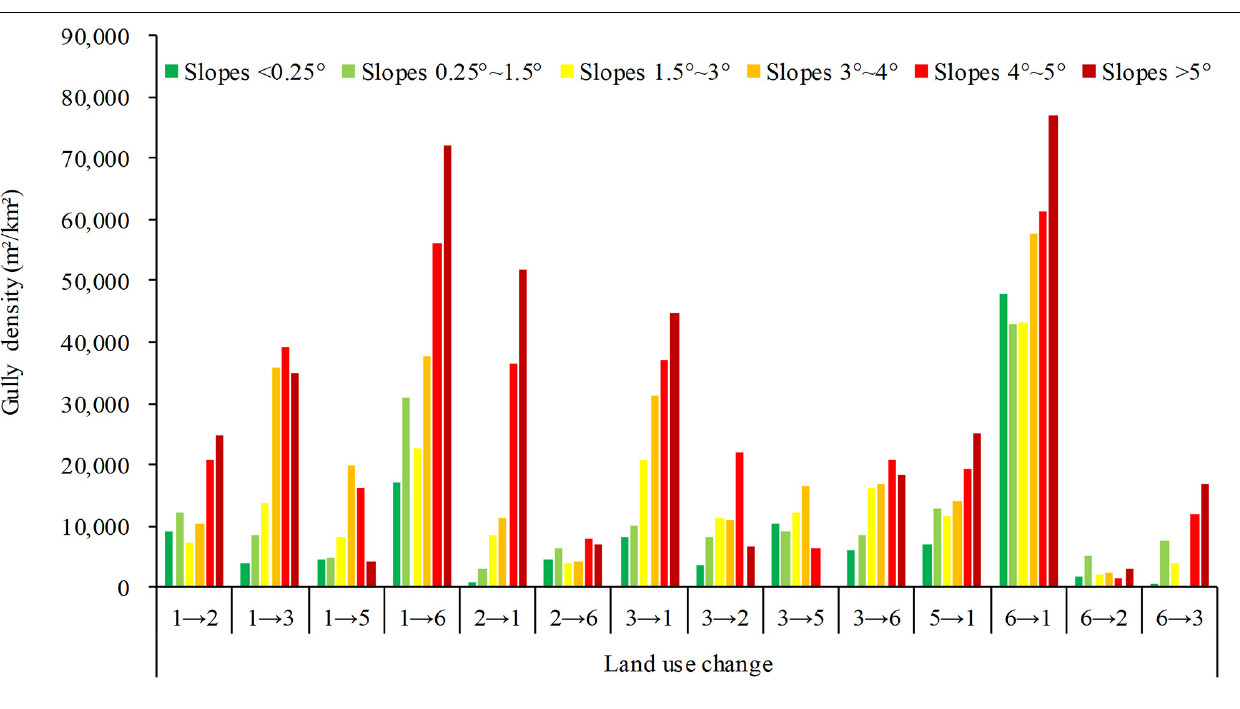
FIGURE 10 | Change of gully erosion density caused by conversion of land use under different slopes from 1965 to 2015. Key: 1 cultivated land, 2 forestland, 3 wetland, 5 construction land, 6 other/degraded, 1 → 2 represents the conversion from cultivated land to forestland, and remaining